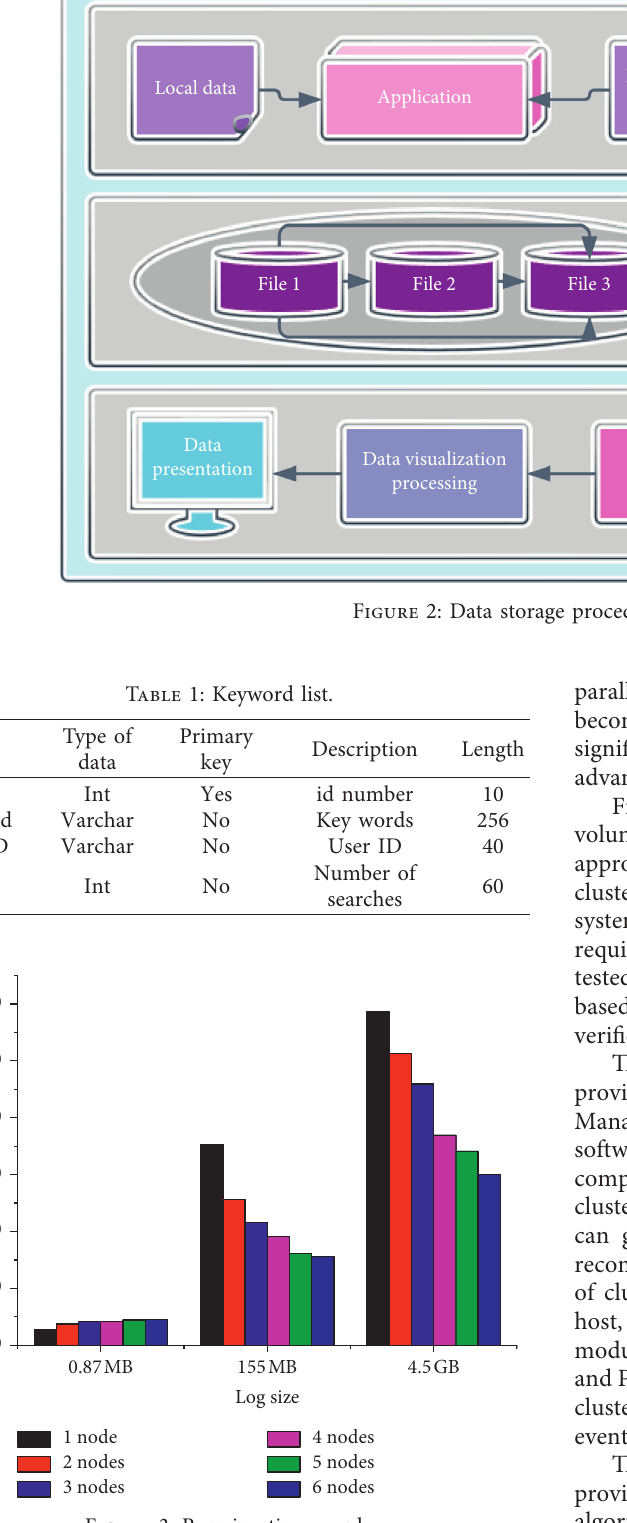
Figure 3: Running time